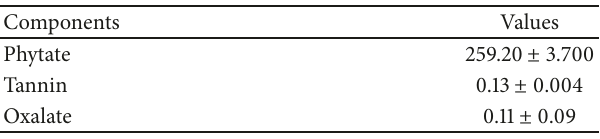
Table 3: Antinutritional factors of cactus pear seed (mg/100g, dry basis).